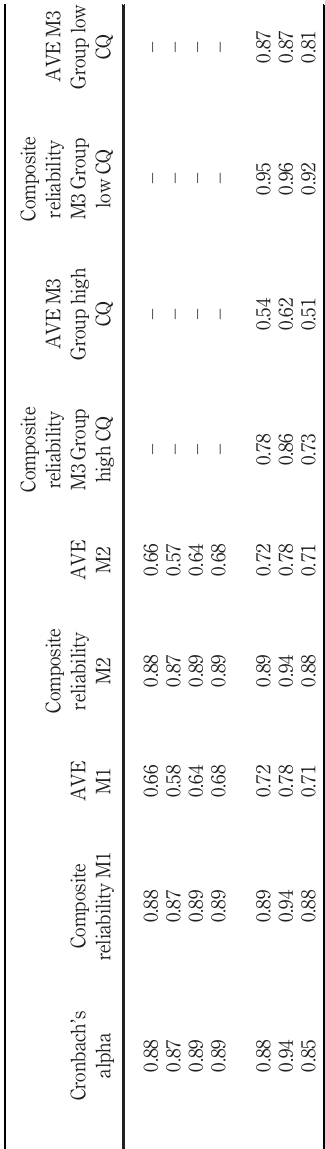
Table V. Composite reliability and average variance extracted of the